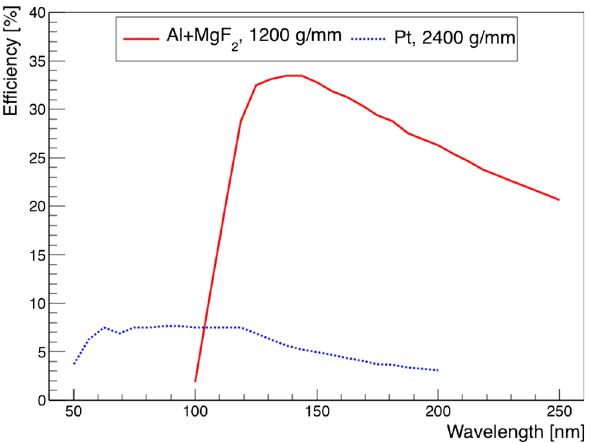
Fig. 4 A comparison of the reflective efficiecnies for an Al + MgF 2 coated grating and a Platium (Pt) coating grating. Plot data provided by McPherson Inc. [28]